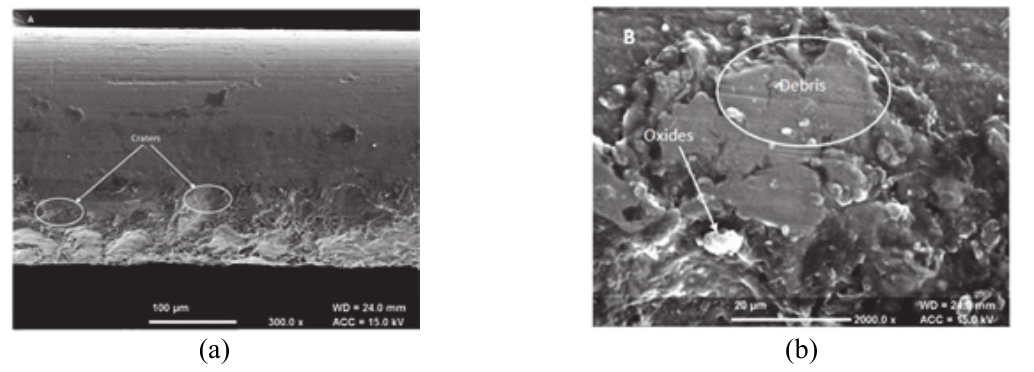
Fig. 3. Microsturcture changes was also observed for the tool electrode due to thermal stresses developed at interaface of tool and